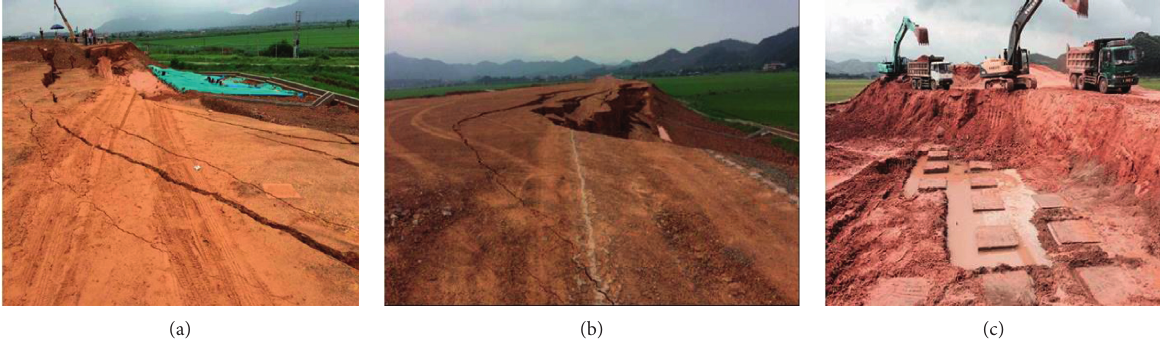
Figure 2: Sliding failure of the embankment. (a) Sliding of the left embankment. (b) Sliding of the right embankment. (c) Excavation investigation.